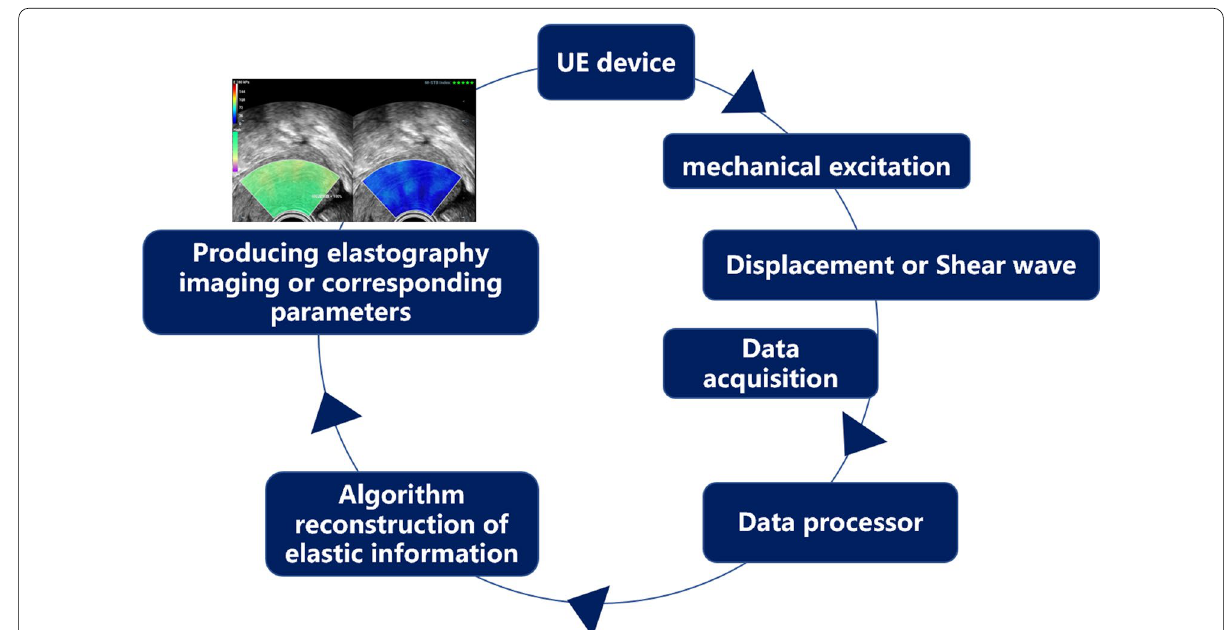
Fig. 2 Flow chart of ultrasound